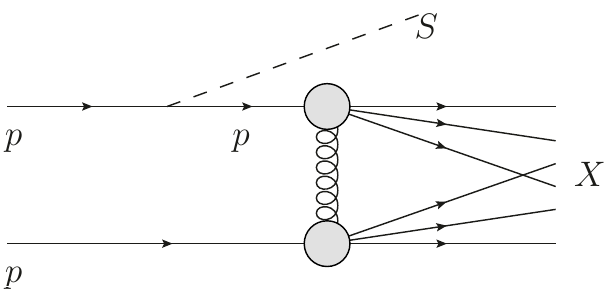
Figure 15 . A diagram of the production of a scalar in the proton bremsstrahlung